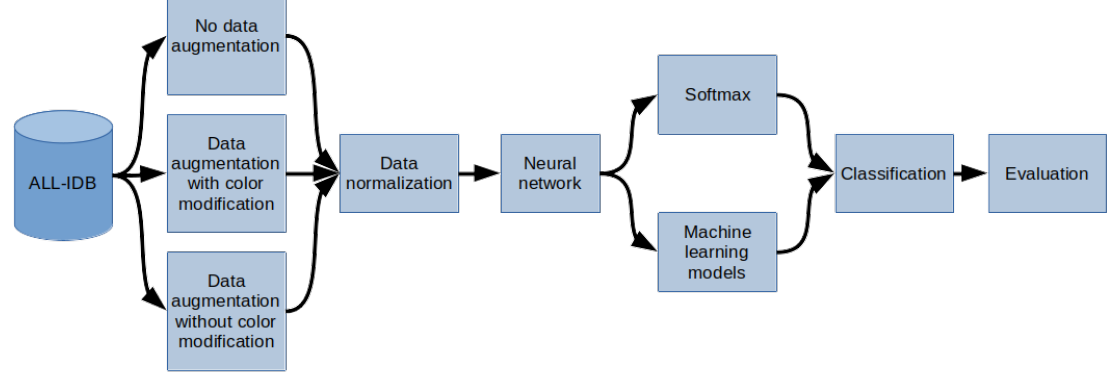
Figure 1. General overview diagram of the method.